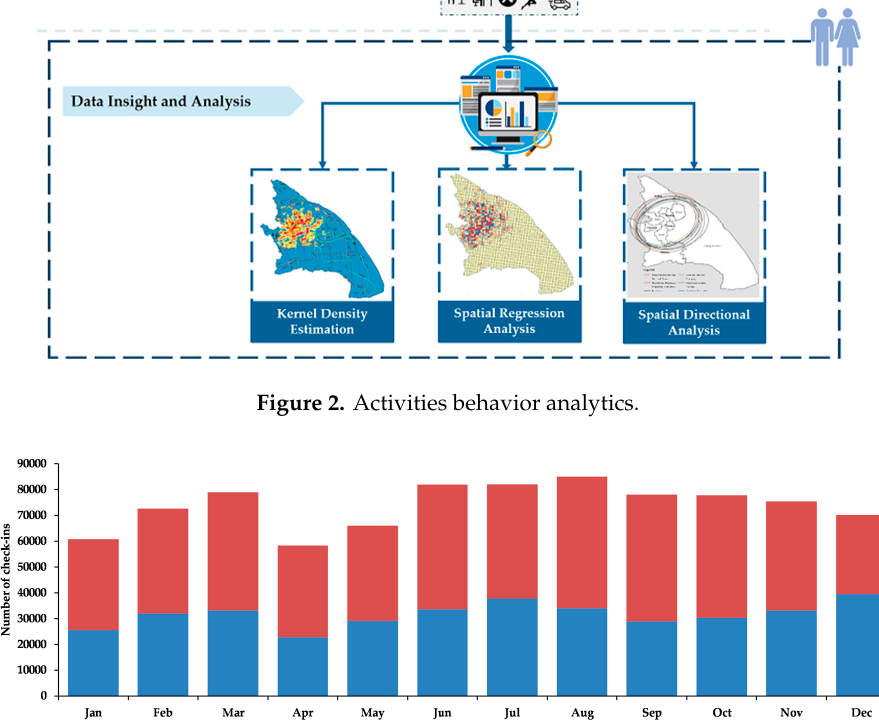
Figure 2. Activities behavior analytics.